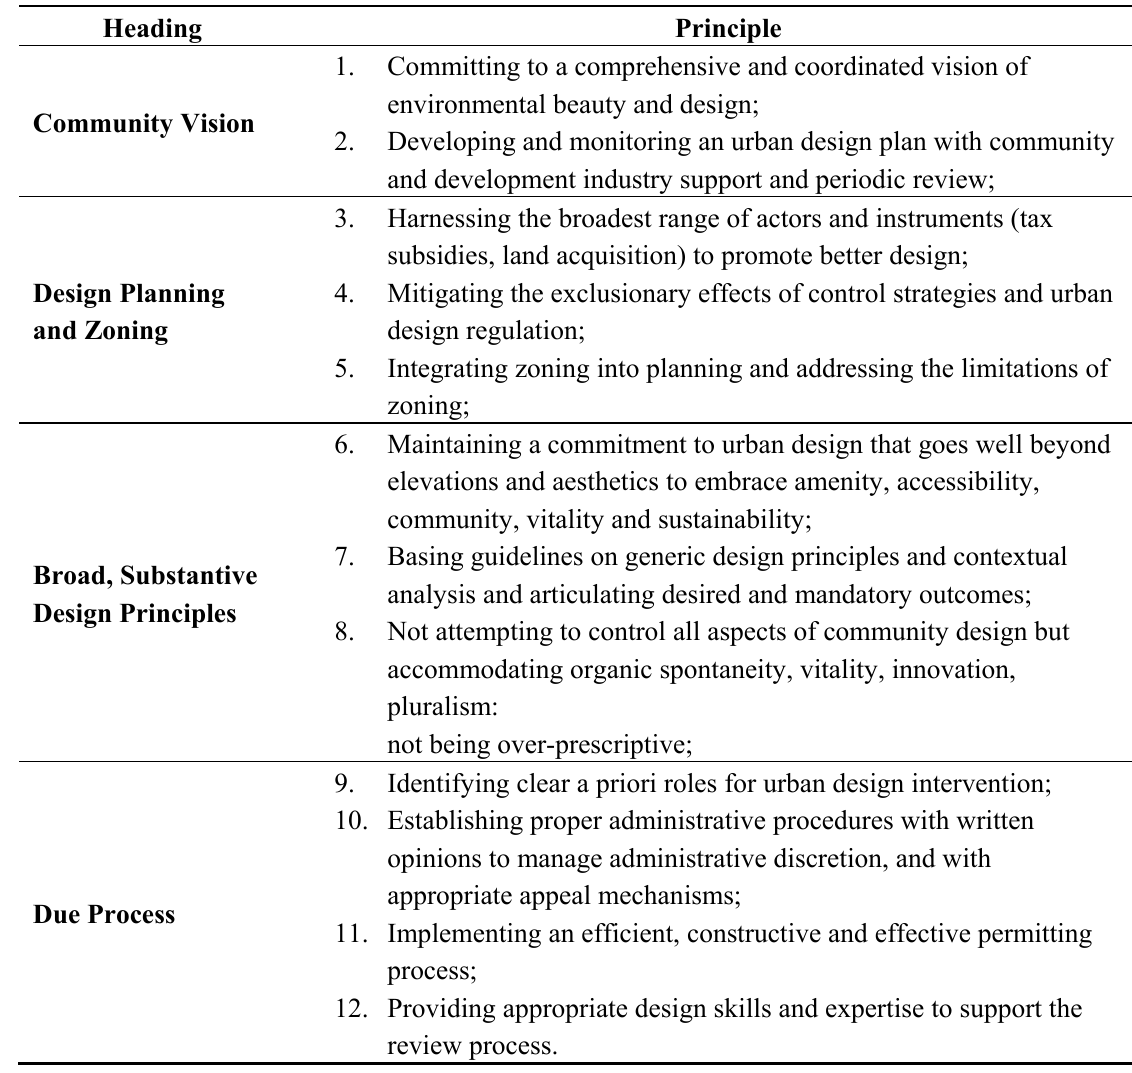
Table 1. Principles for progressive design review. Source: Punter